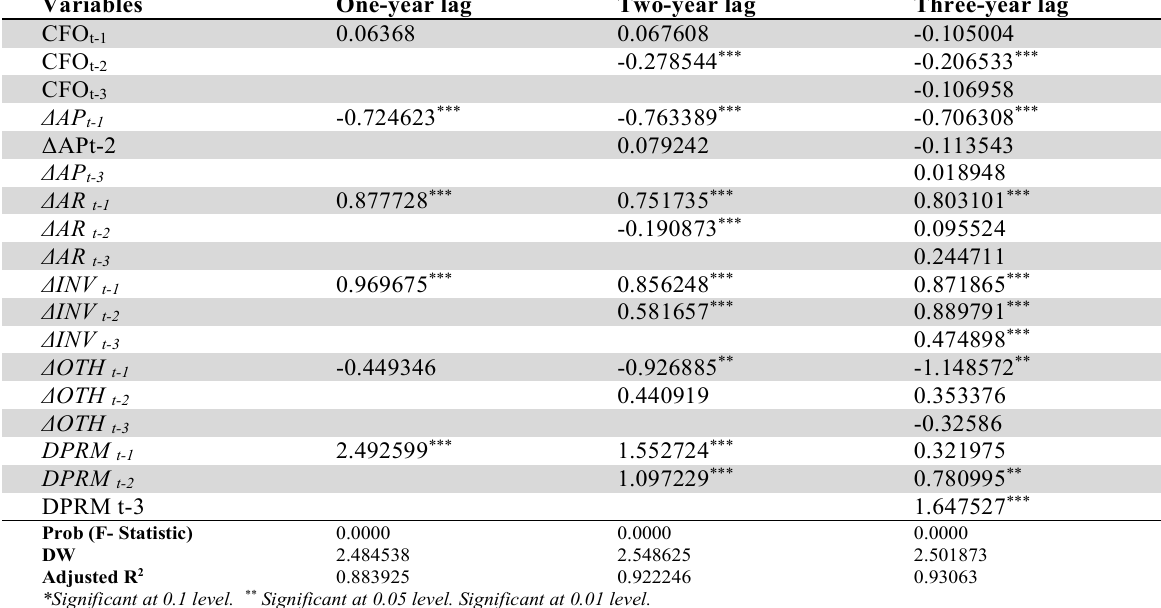
Summary of FEM regression results of the cash flow model combined with the disaggregated accruals